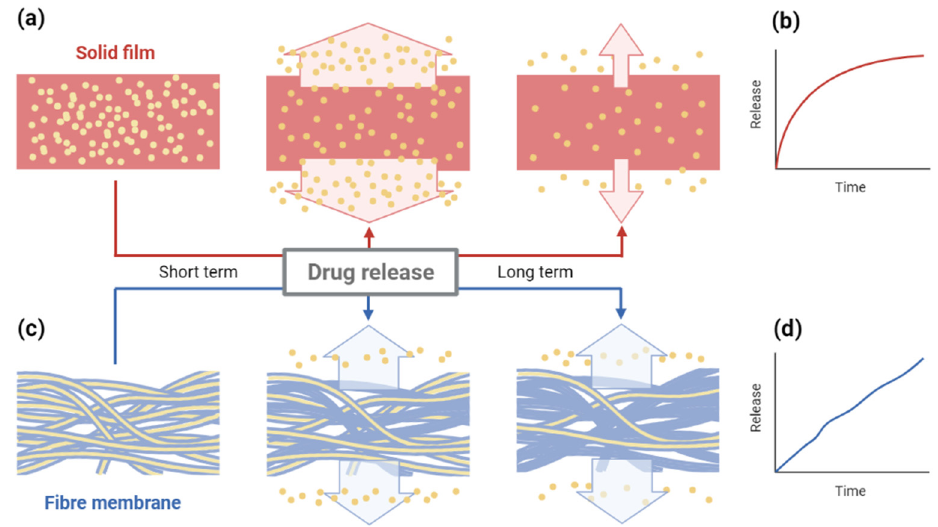
Figure 5. Comparison of drug release process and kinetics between ( a , b ) solid film and ( c , d ) multi- layered fibre membrane wafer. Created with BioRender.com and adapted from [70].